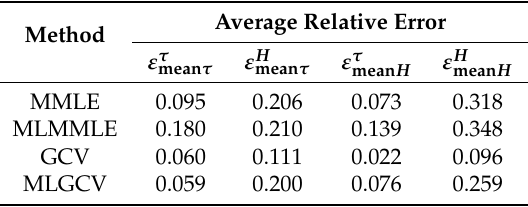
Table 3. Average relative errors for the results plotted in Figures 3 and